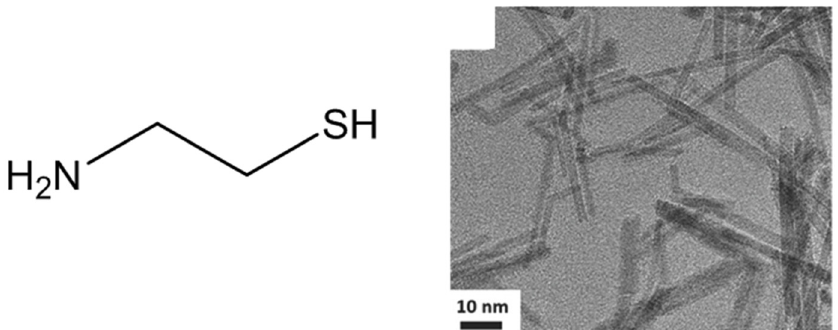
Figure 15. Chemical structure of 2-mercaptoethylamine and TEM image of the IrO 2 nanoneedles (Reprinted/adapted with permission from Ref. [75]).